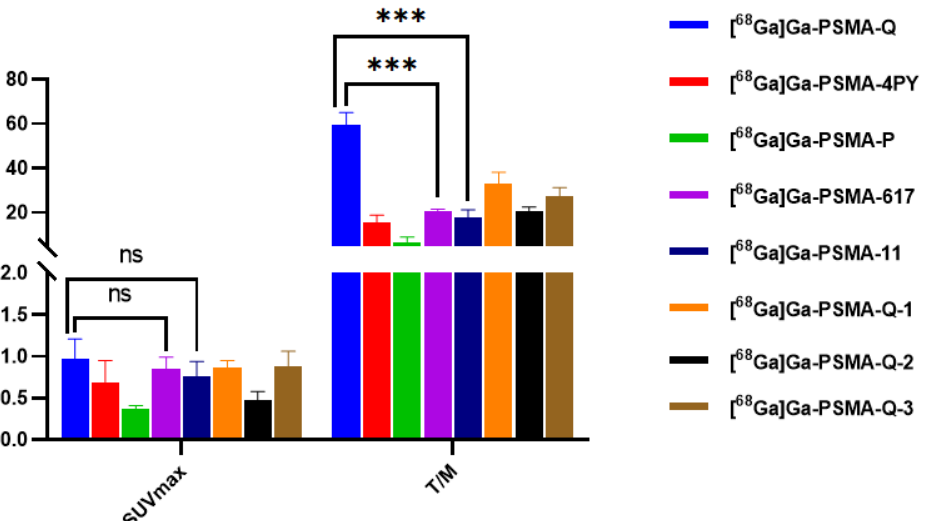
Figure 8. SUVmax of tumors and T/M values of novel tracers as well as [ 68 Ga]Ga-PSMA-617 and [ 68 Ga]Ga-PSMA-11 in 22Rv1 tumor-bearing mice at 60 min p.i. (*** p < 0.001).